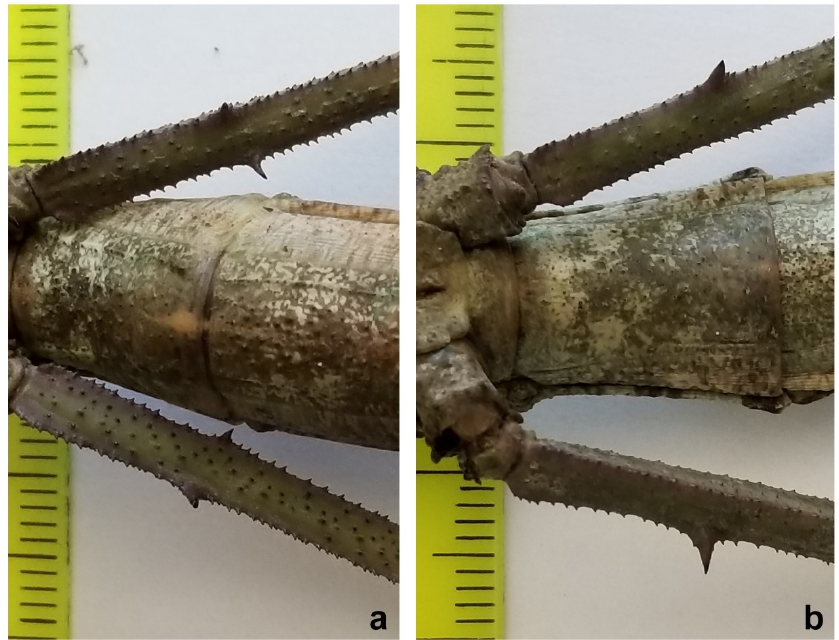
Figure 3. Femur of the hind legs: ( a ) Cladomorphus petropolisensis presenting two bigger spines; ( b ) C. phyllinus presenting one bigger spine.